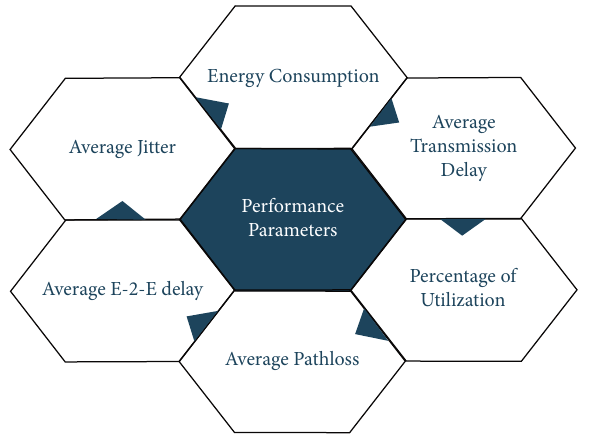
Figure 8: Performance parameters of the UWSN.